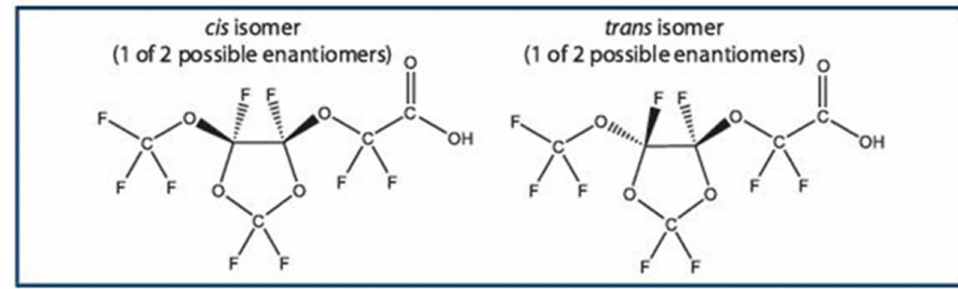
Figure 1. A single enantiomer of each cis/trans isomer of